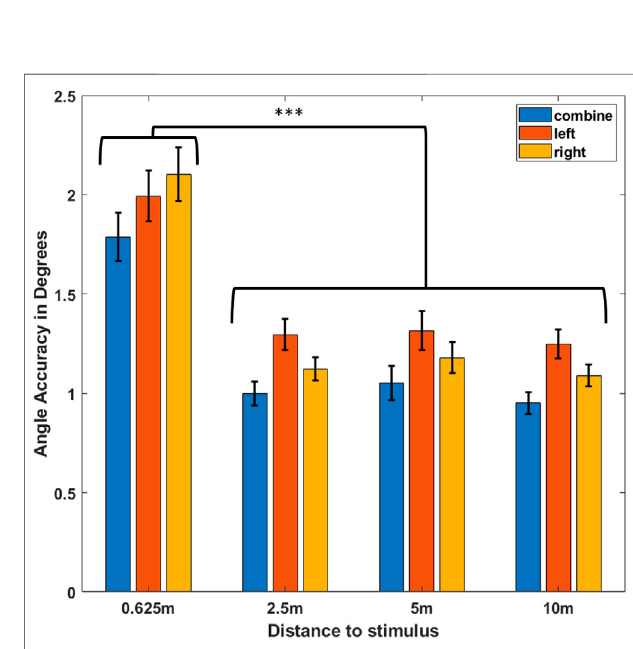
FIGURE 6 | Average angular accuracy for combine (blue), left (orange), andright(yellow)eyesateachtargetdistance.Angularaccuracyissigni fi cantly worse for targets presented at 0.625 m than at other distances. Combine eye angular accuracy appears slightly better than either eye individually, but the differences are not signi fi